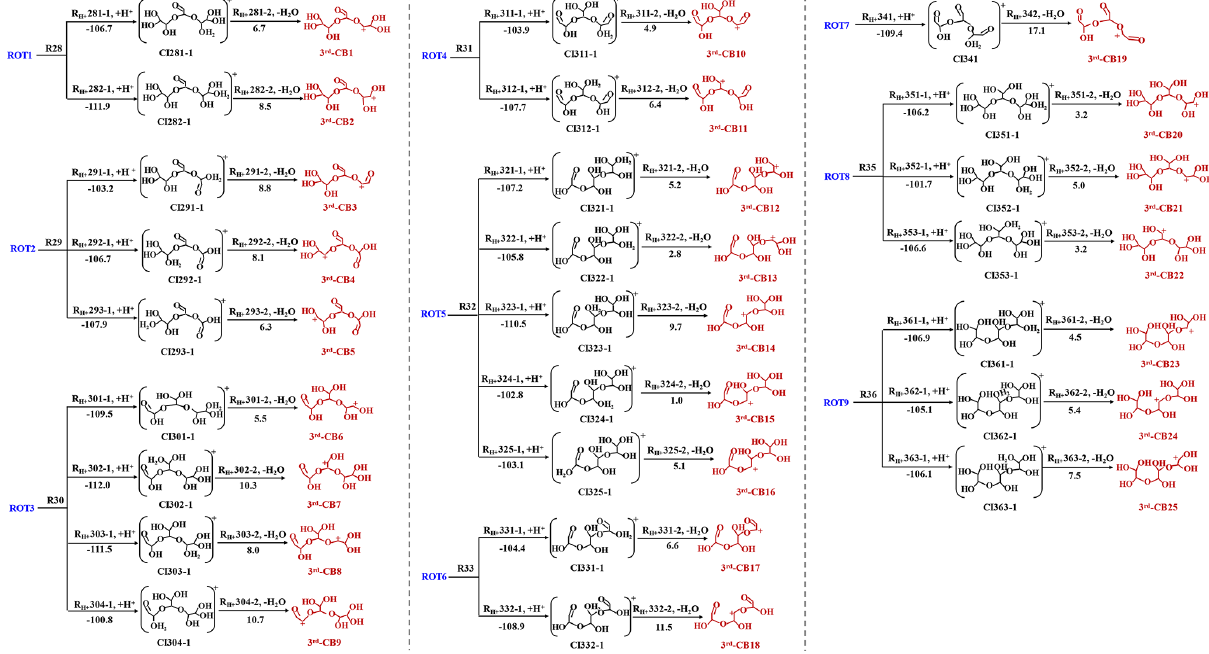
Figure 3. The formation of 3rd-CBs from the ring-opening trimers (in kcalmol − 1 ). The value represents the (cid:49)G r of each step